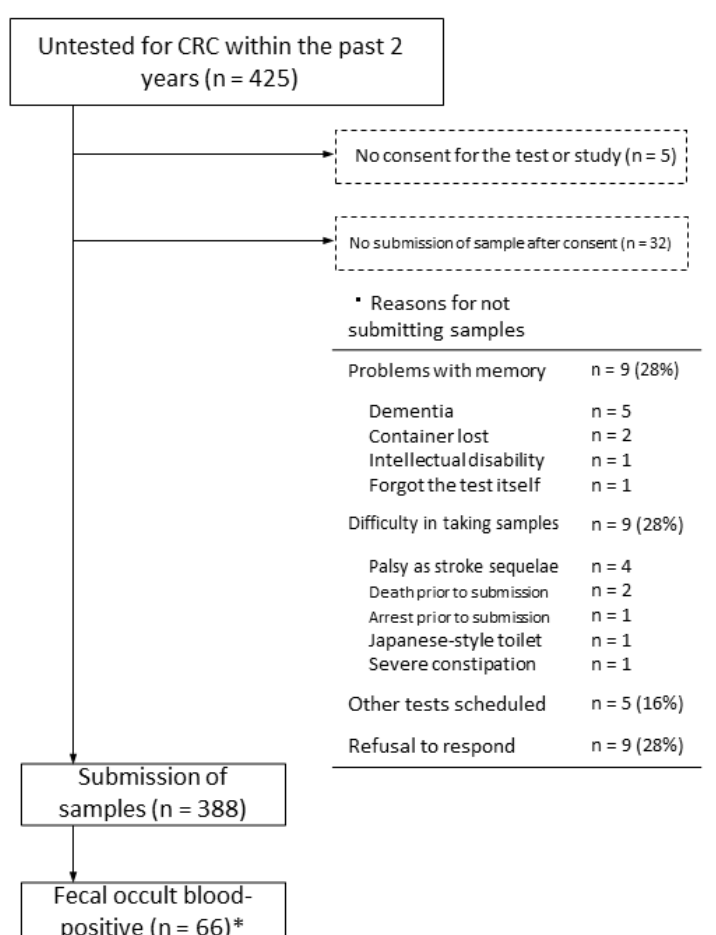
Table 1. Characteristics of fecal occult blood-positive